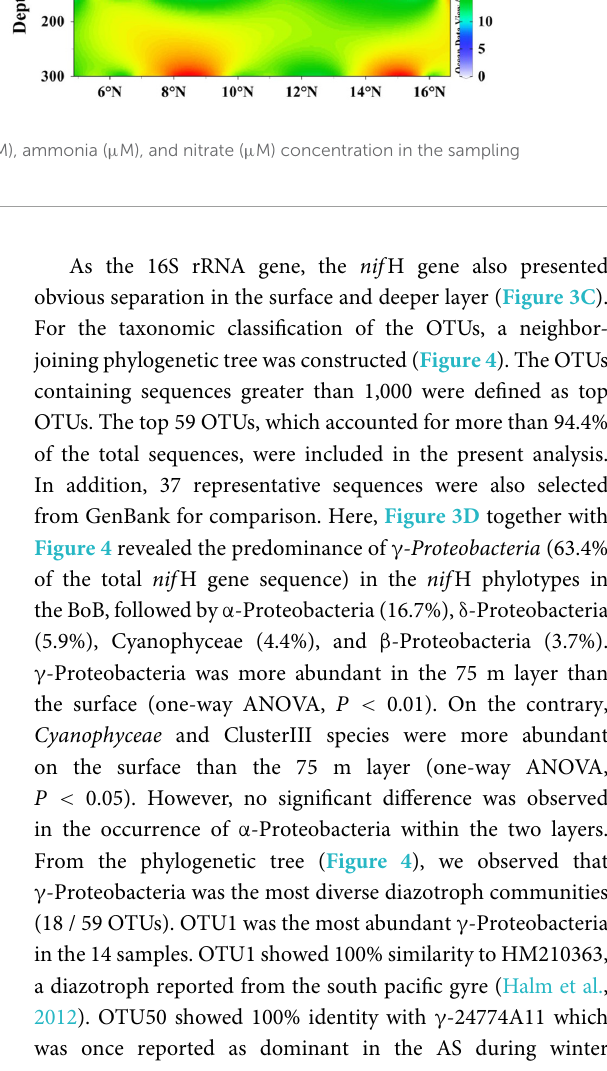
most fractions of Bacteriodetes, which accounted for